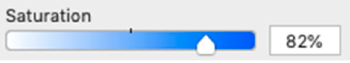
Figure 4. Saturation Spectrum.